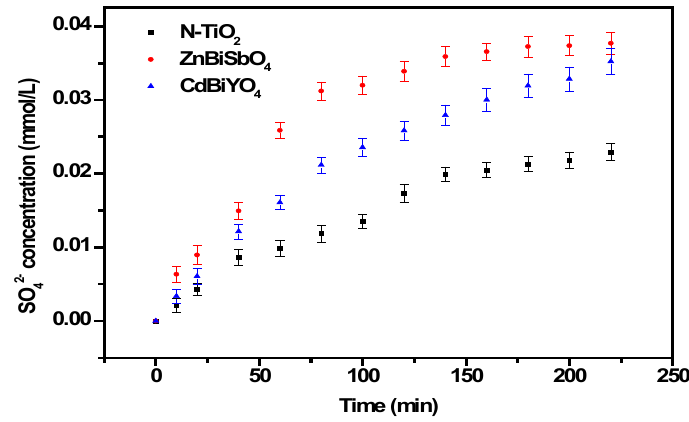
Figure 14. SO 42− production during the photocatalytic degradation of IC with ZnBiSbO CdBiYO and N-TiO as photocatalysts, respectively, under visible light irradiation. 4 2 The results are the means of triplicates, and error bars represent ±1 SD.